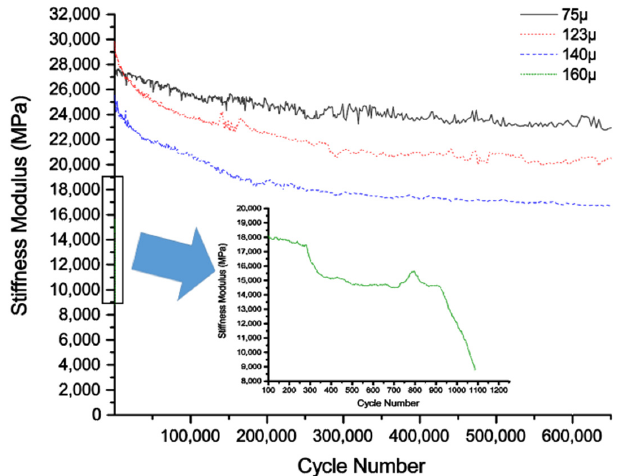
Figure 4. Trial test of rigid pavement at 75 microstrains, 123 microstrains, 140 microstrains and 160 microstrains.